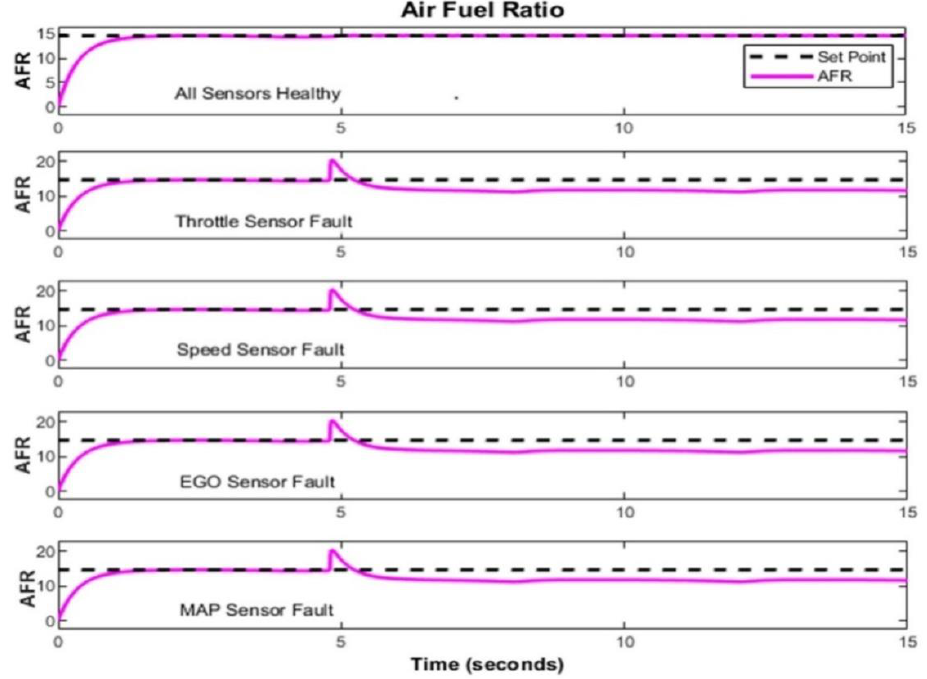
Figure 12. Performance of AFTCS.